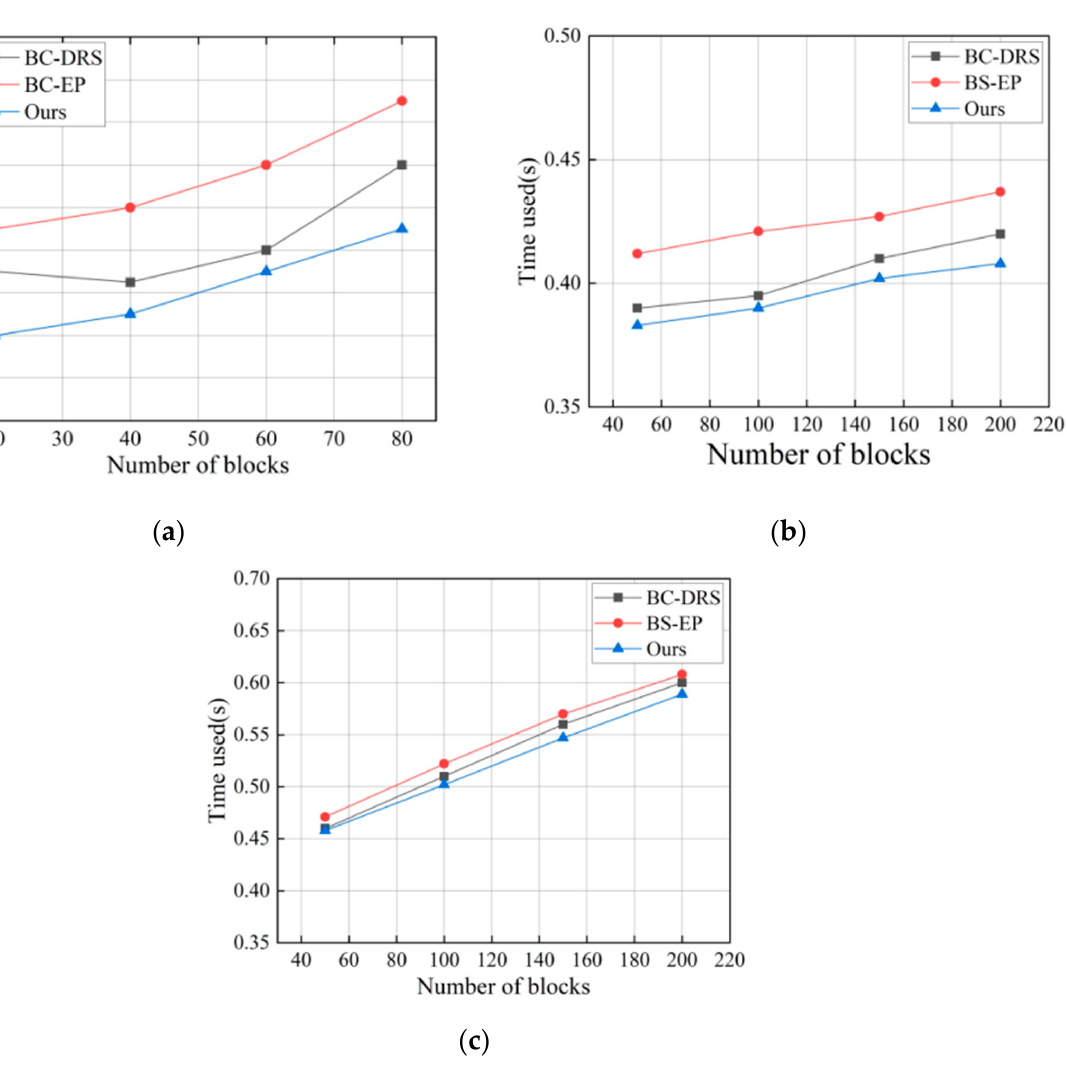
Figure 8. The time cost of invoking smart contracts: ( a ) Time cost of commodity upload function; ( b ) Identify the time cost of purchasing features; ( c ) Time overhead of sign-in and evaluation functions.